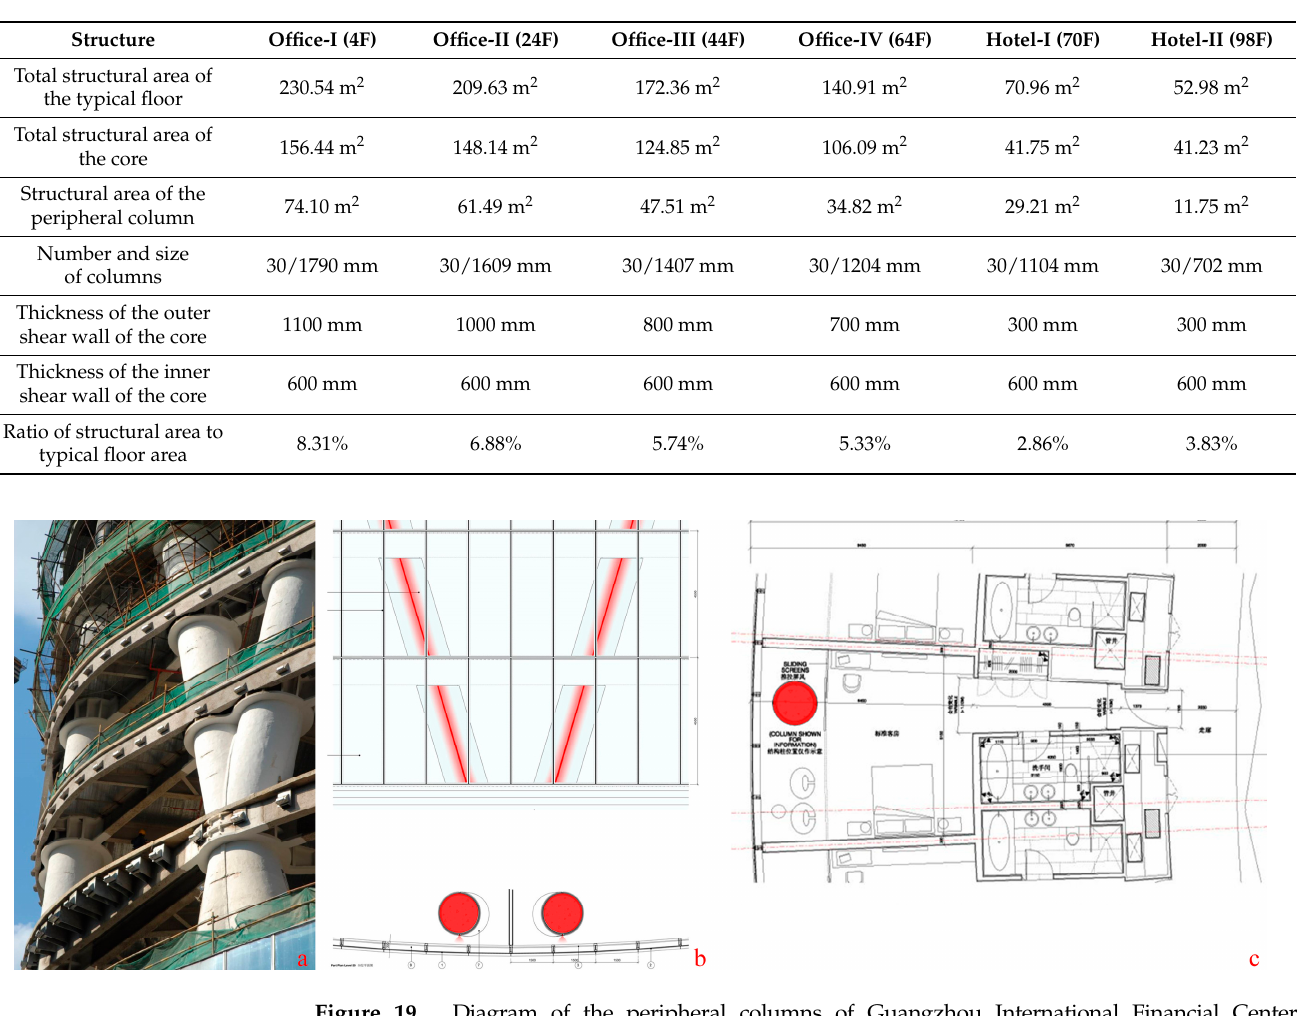
Table 7. Dimensions of structural components of Guangzhou International Financial Center.